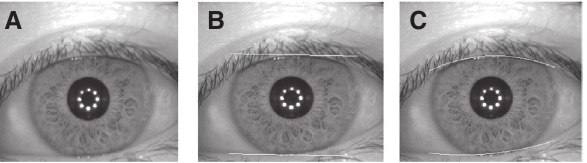
Figure 11. Upper and Lower Eyelid Detection with Masek’s and Our Approach. (A) Original image. (B) Masek approach. (C) Our